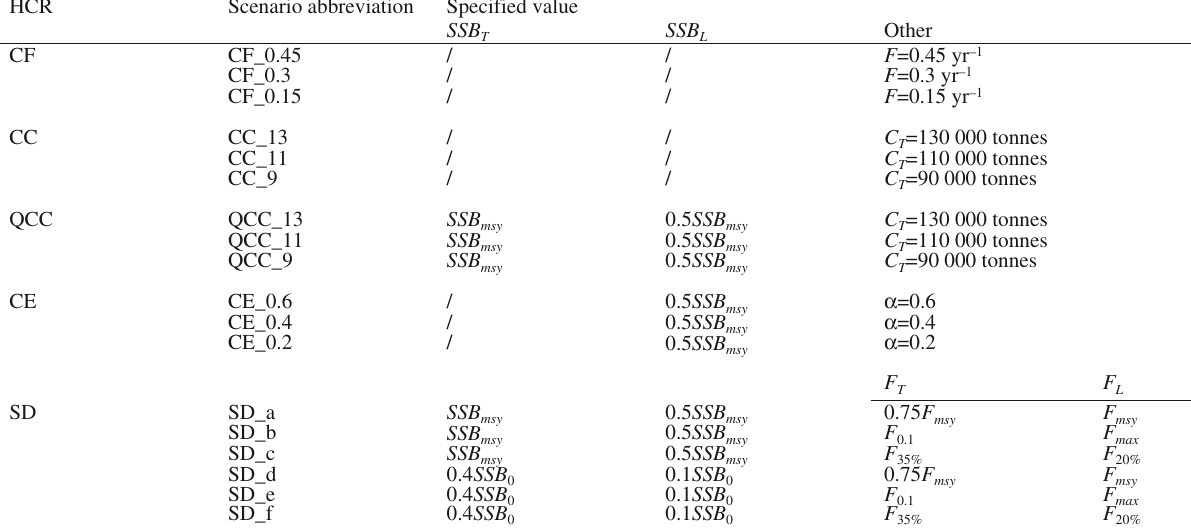
Table 2. – Parameter values used in each management scenario (HCR, harvest control rule; CF, constant fishing mortality; CC, constant catch; QCC, quasi-constant catch; CE, constant escapement; SD, status-dependent